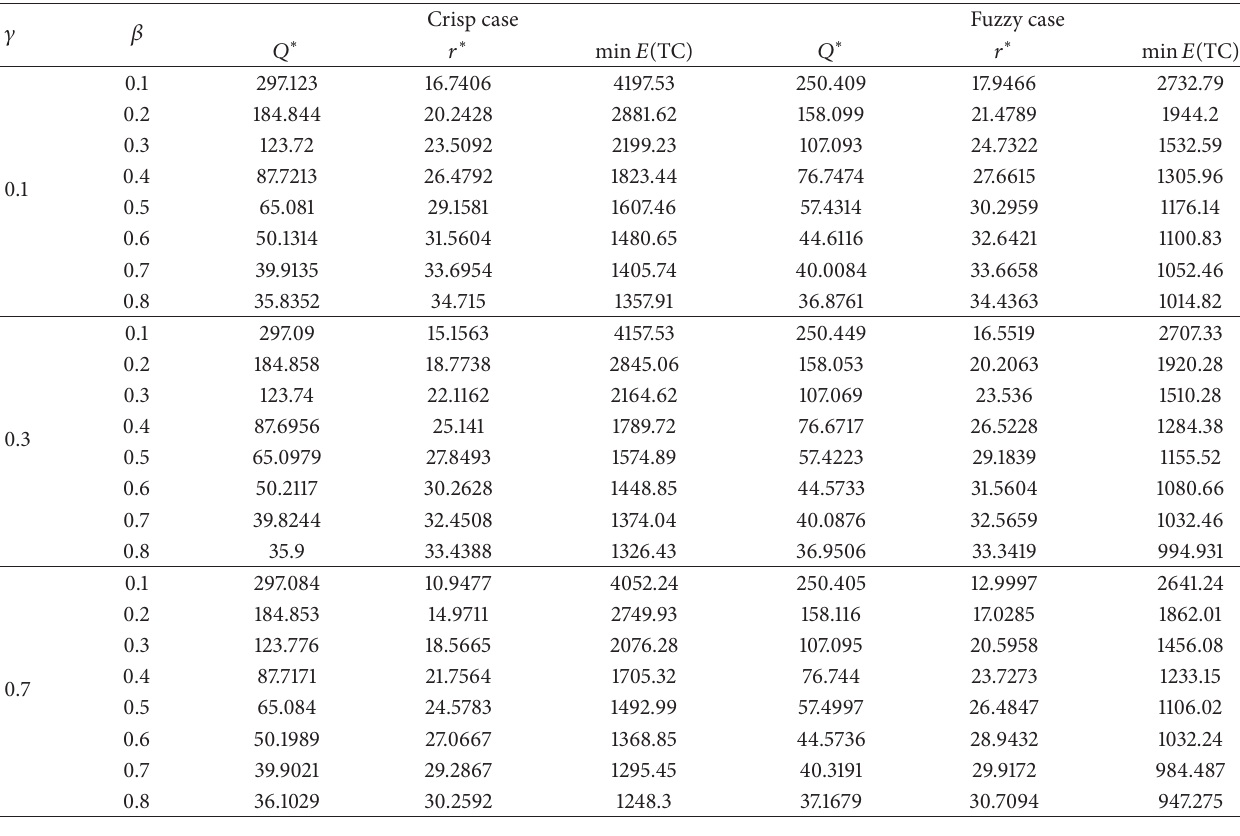
∗ = 29.3328 and reorder point 𝑟